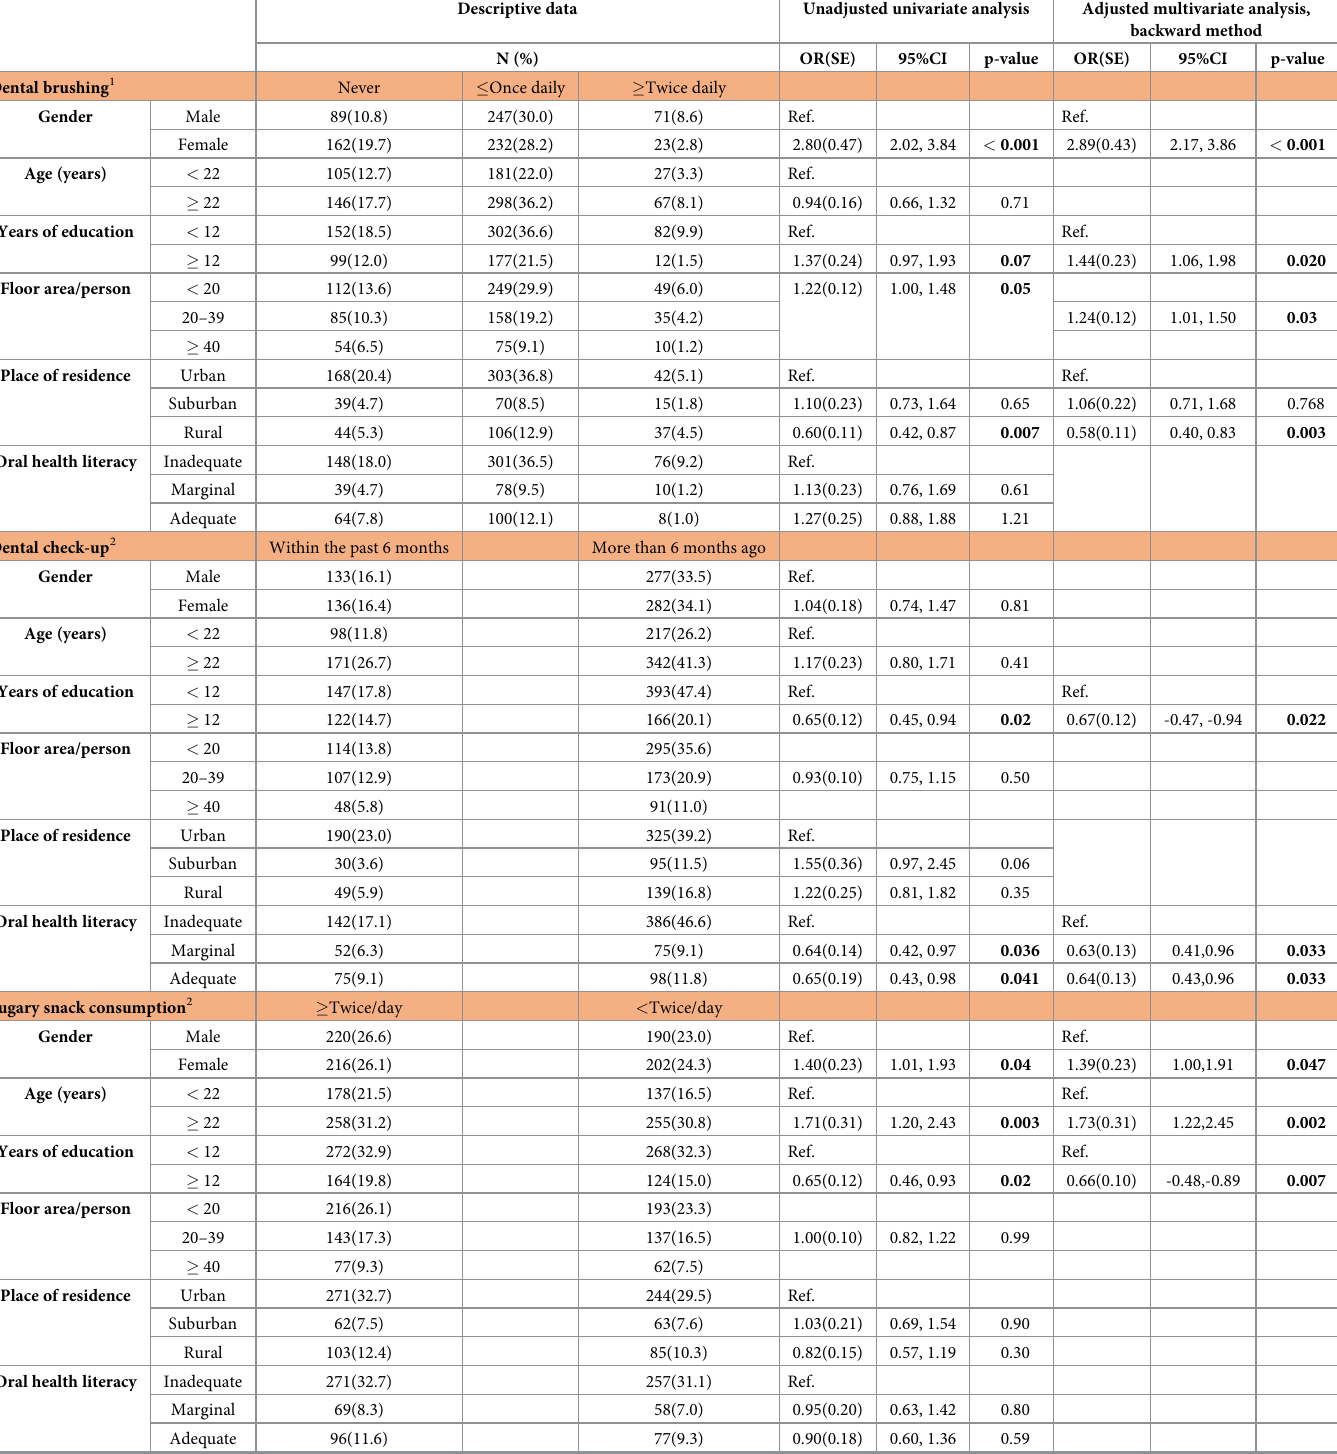
Table 1. Oral health literacy and demographic characteristics as well as their relationship with oral health preventive behaviors of the participants